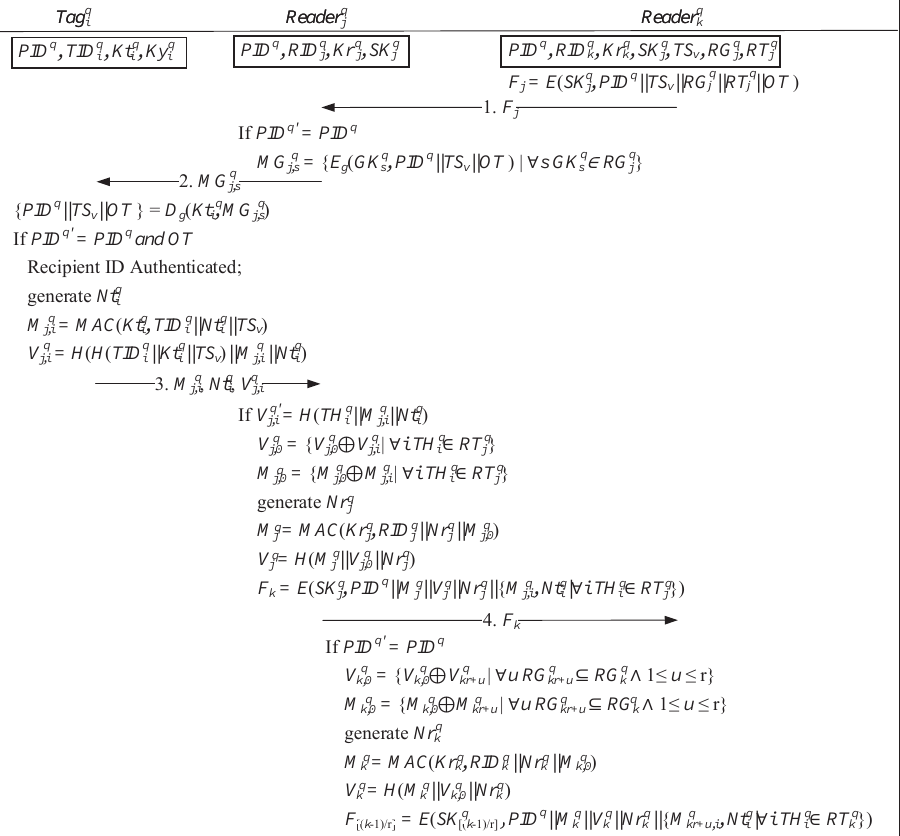
Figure 3. Generating grouping proofs by using a multilayered